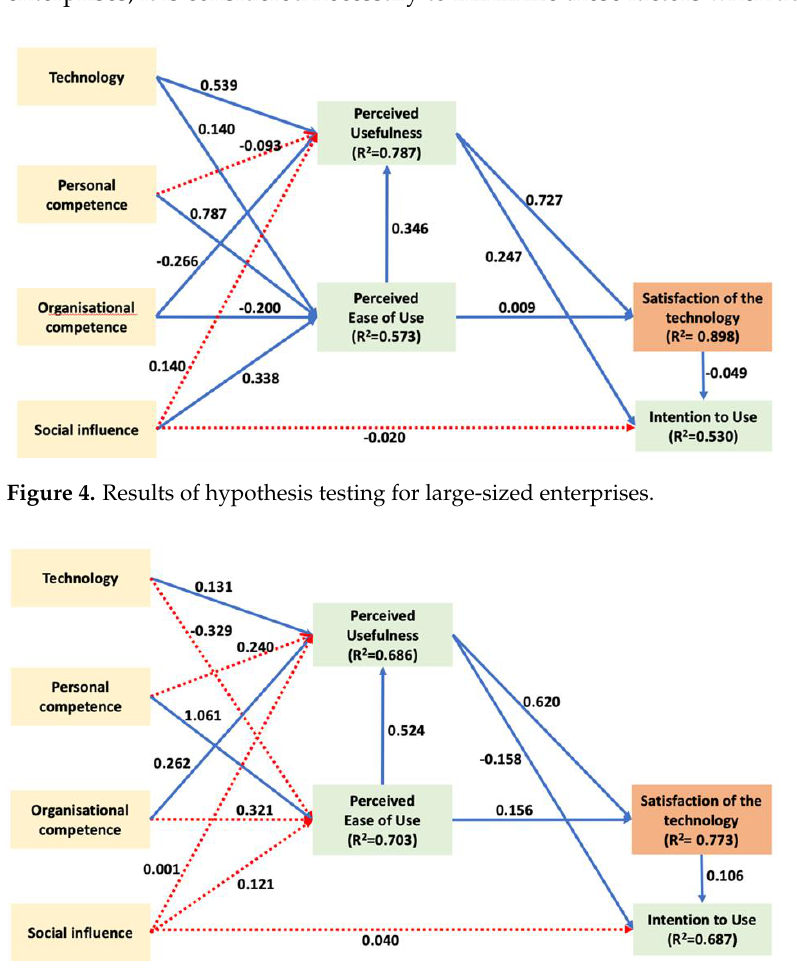
Figure 5. Results of hypothesis testing for small and medium-sized enterprises.